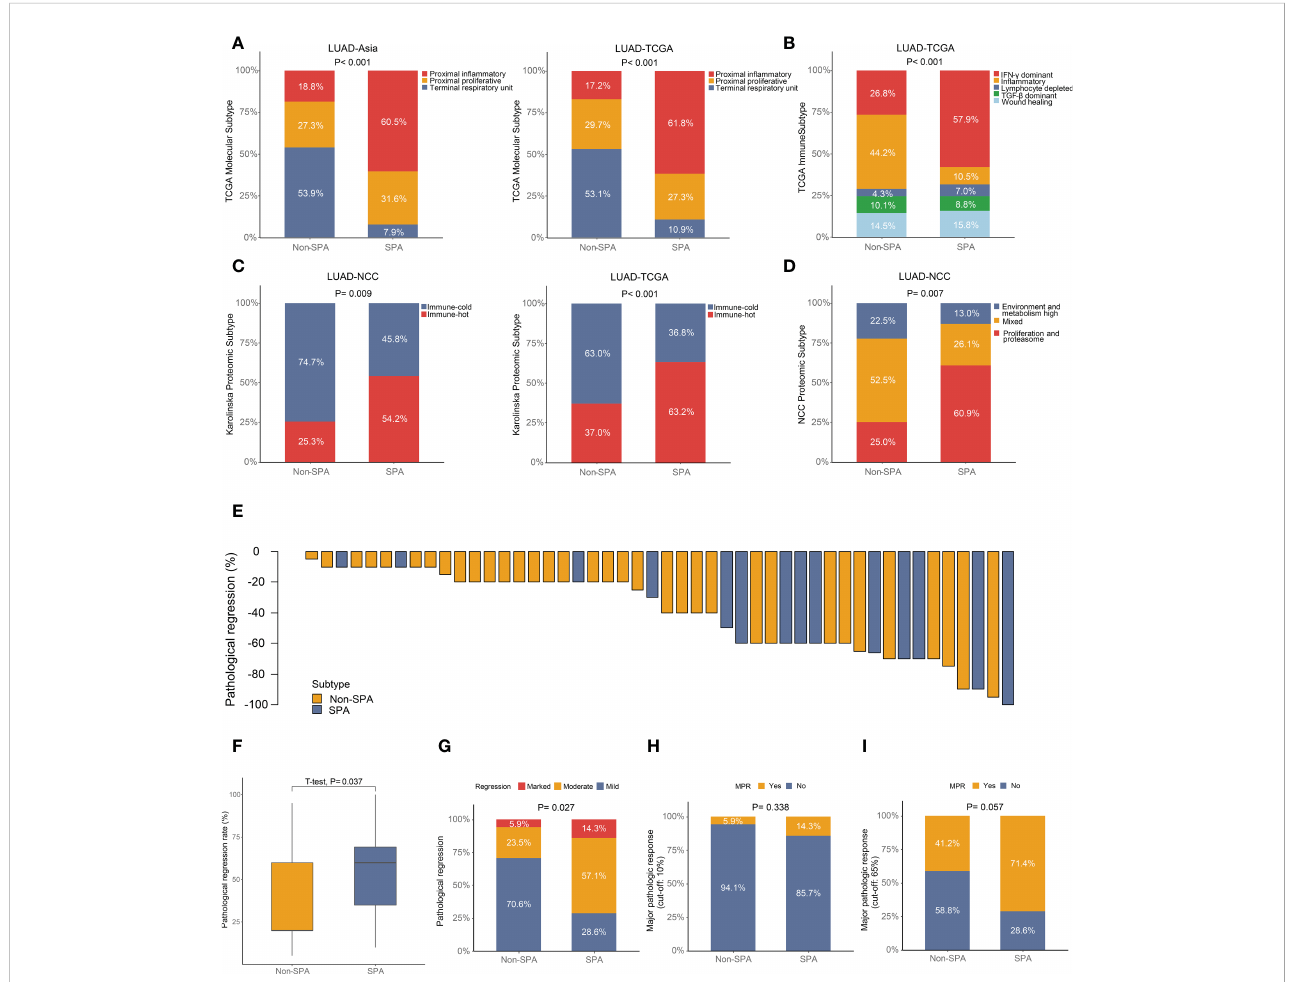
FIGURE 7 Association of published transcriptomic or proteomic subtypes with pathological subtypes and neoadjuvant immunotherapy ef fi cacy in SPA versus Non-SPA. (A) Percentage of TCGA molecular subtypes in SPA and Non-SPA. (B) Percentage of TCGA immune subtypes in SPA and Non-SPA. (C) Percentage of Karolinska proteomic subtypes in SPA and Non-SPA. (D) Percentage of NCC proteomic subtypes in SPA and Non-SPA. (E) Pathological regression rate in each patient. (F, G) Comparison of pathological regression between SPA and Non-SPA. (H, I) Comparison of major pathological response between SPA and Non-SPA. SPA, solid predominant adenocarcinoma; Non-SPA, non-solid predominant adenocarcinoma; MPR, major pathological